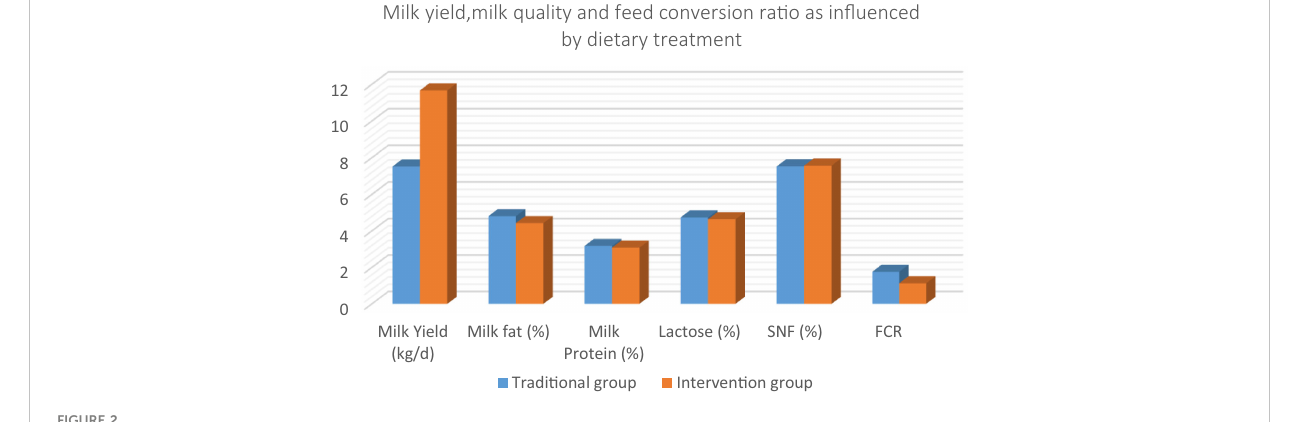
FIGURE 2 Milk yield, quality and feed conversion ratio as in fl uenced by dietary